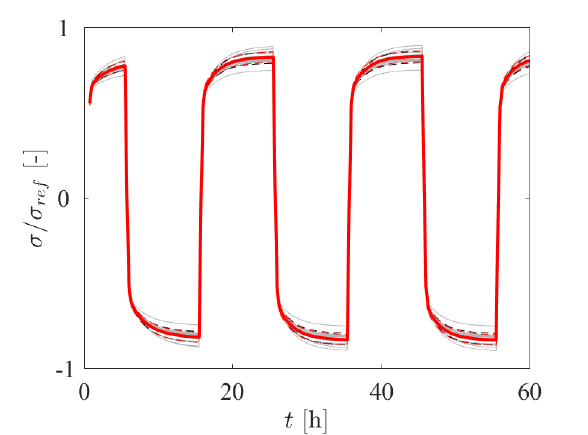
Figure 4. Comparison of synthetic observations (black) with model responses (red) corresponding to the identified parameters’ distribution in a form of mean value ± standard